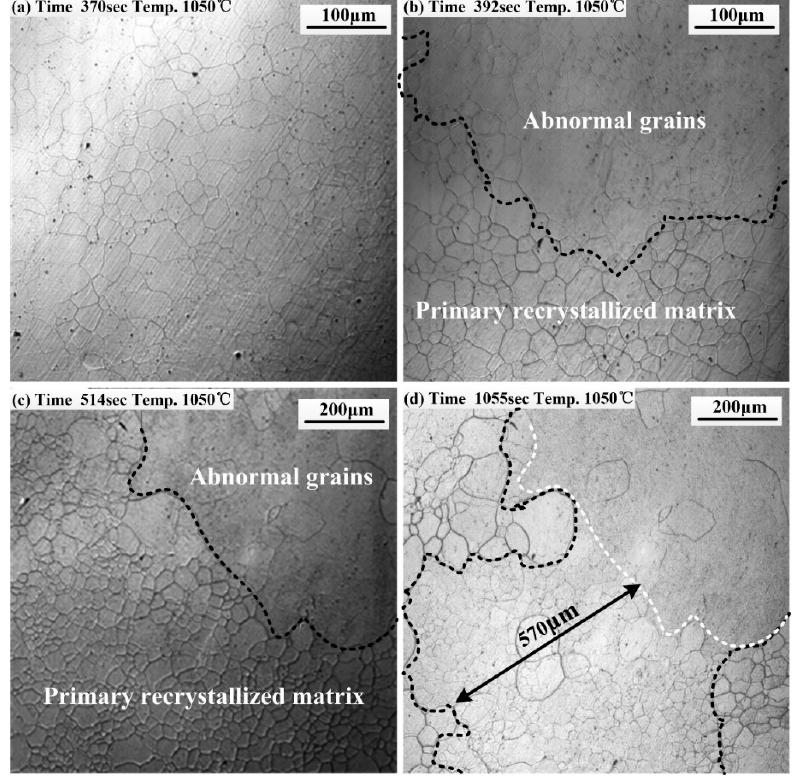
Figure 5. Microstructure evolution of weak inhibition specimens during secondary recrystallization by CLSM (intermediate annealed for 20 h). ( a ) 370 s; ( b ) 392 s; ( c ) 514 s; ( d )1055 s.